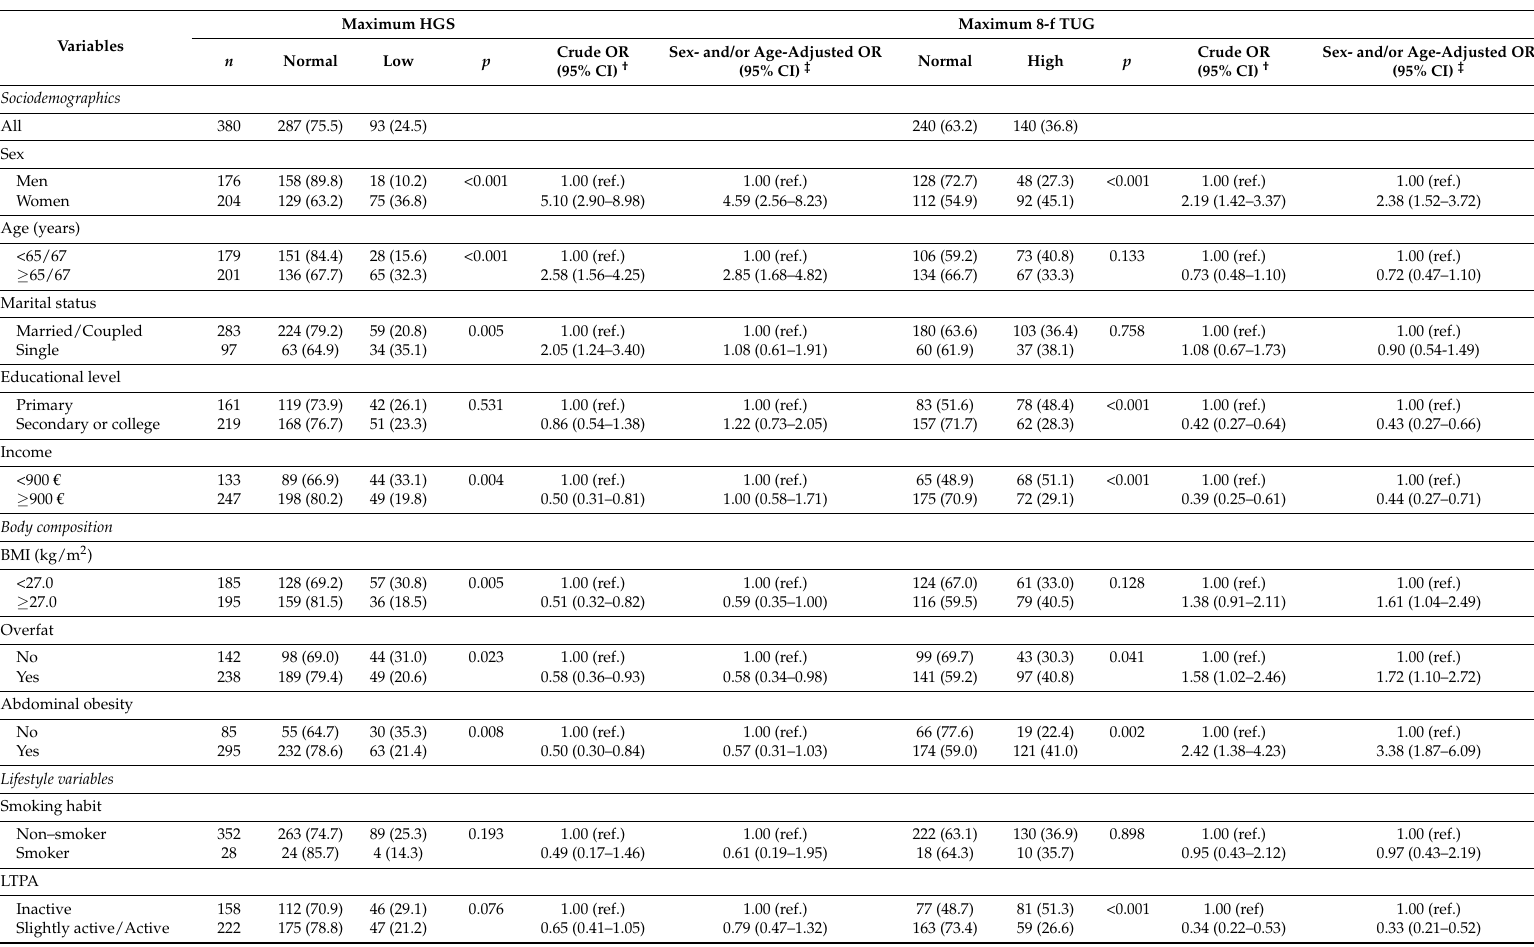
Table 2. Prevalence of low/normal maximum HGS and high/normal 8-f TUG score according to sociodemographic, body composition, and lifestyle variables. Maximum Variables